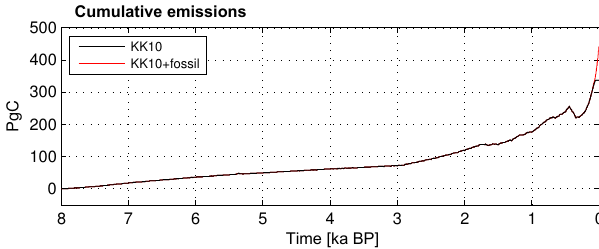
Figure 1. Cumulative carbon emissions from land use (Kaplan et al., 2011; black) and land use and fossil fuel (Meinshausen et al., 2011;